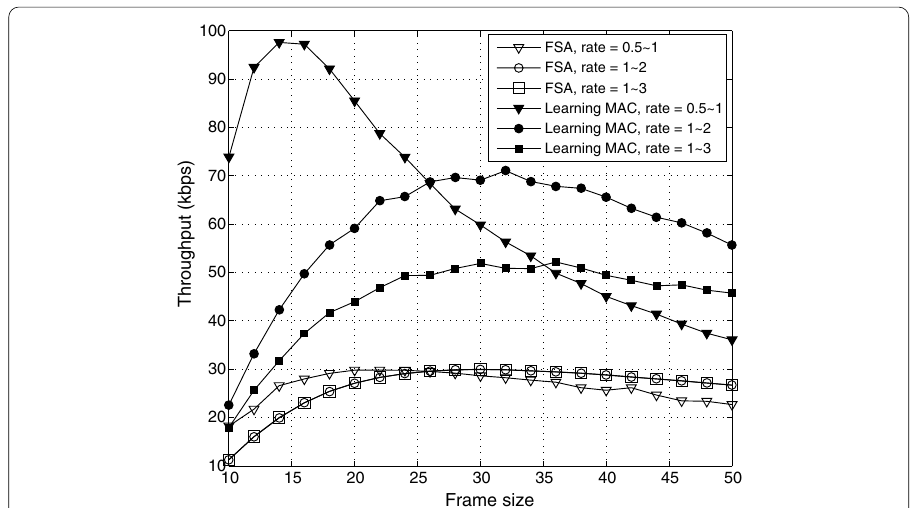
30) for different arrival rates =